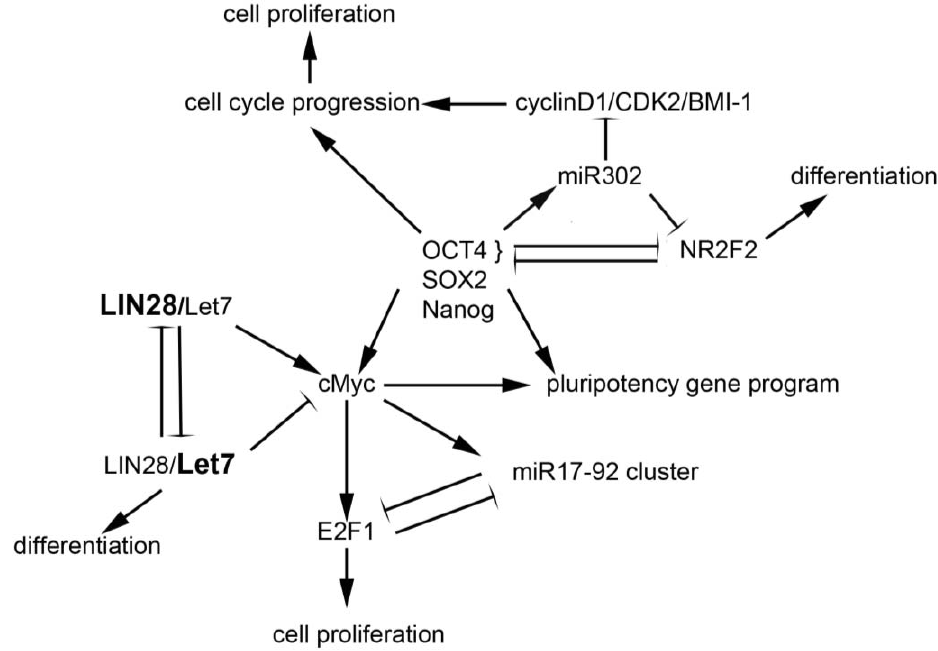
Figure 1. An overview of major gene and miRNA regulators of pluripotency